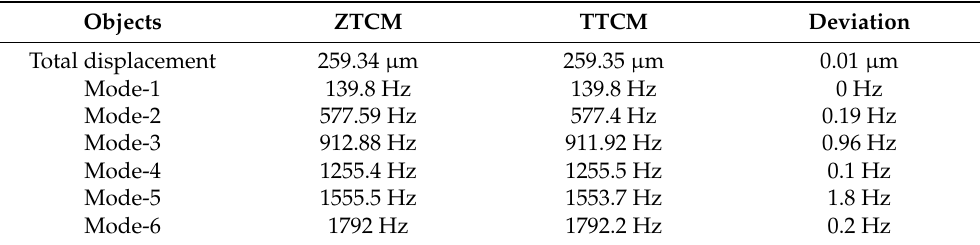
Table 1. Deviation between the ZTCM-based mechanism and the TTCM-based mechanism of static performance and dynamic performance.